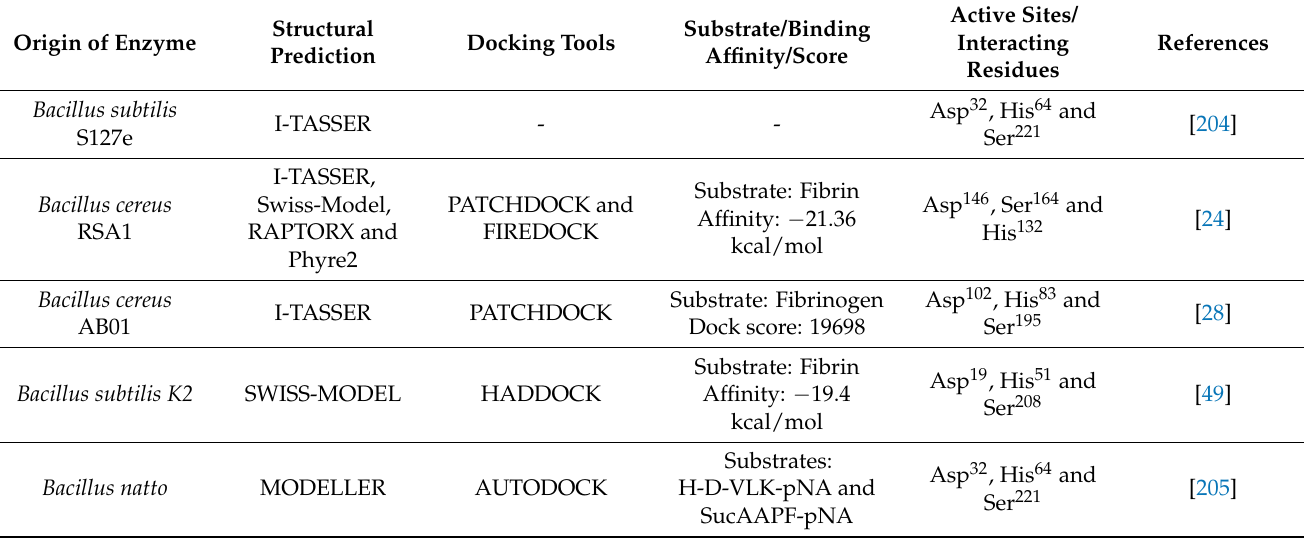
Table 4. Structural-functional characteristics of microbial fibrinolytic